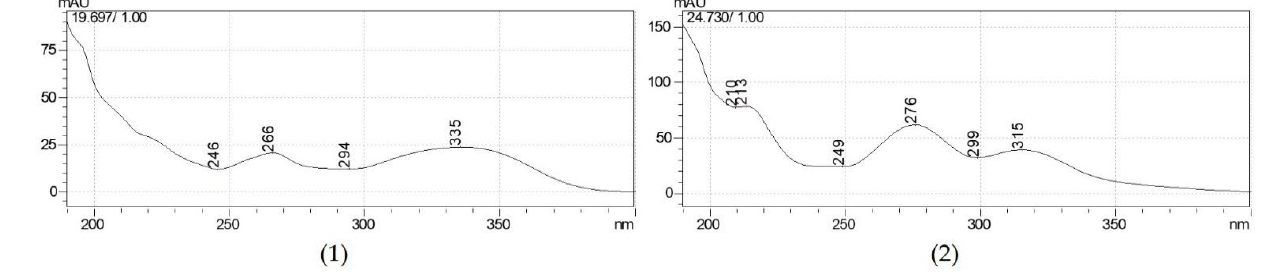
Figure 4. UV-vis spectrum of ( 1 ) A7OG and ( 2 ) baicalin from the 0.1% AE cream pretreated solution with internal standard and standard solution with internal standard. with internal standard and standard solution with internal